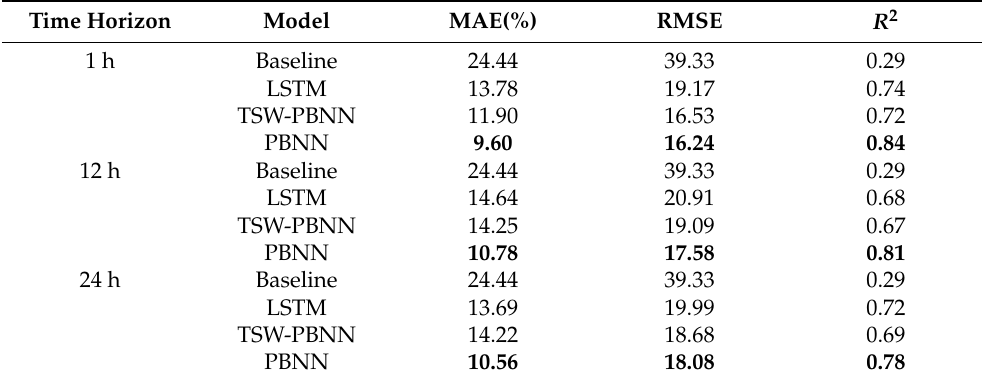
Table 4. Comparison of prediction errors of the baseline model, LSTM, TSW-PBNN, and PBNN. Time Horizon Model MAE(%) RMSE R 2 1